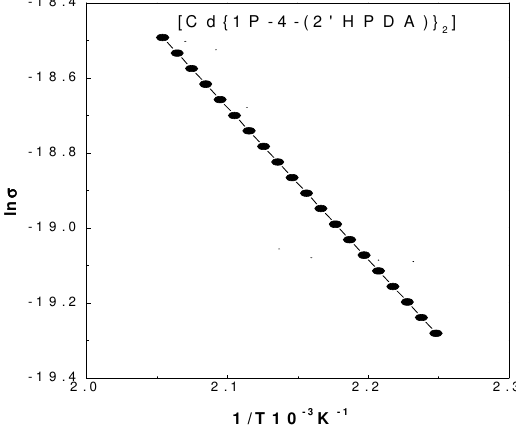
Figure 3. Temperature dependence of electrical